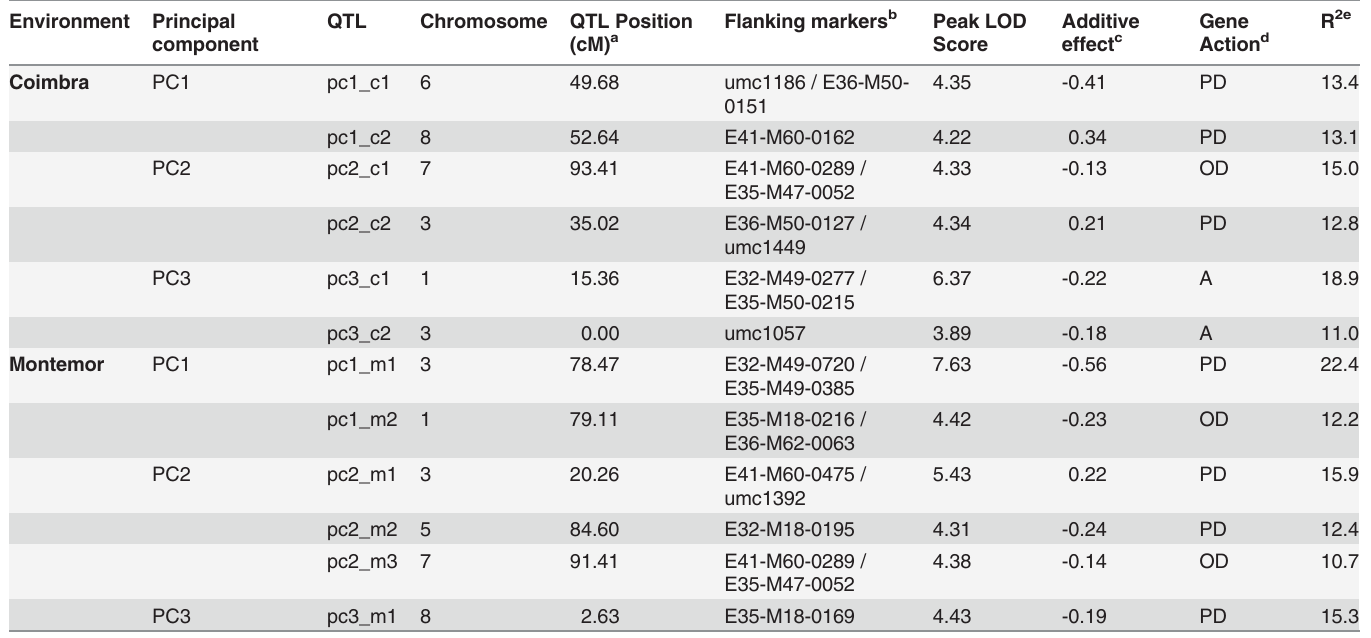
Table 5. Quantitative Trait Loci for the first three PCs, derived from 29 traits in the F 2:3 maize families (PB260xPB266) in two environments. Environment Principal